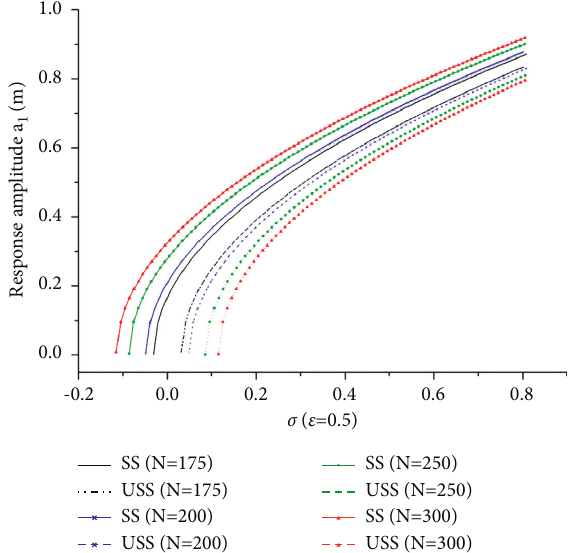
Figure 7: Curve of pedestrian number and lateral response am- � 0 . 007, ε � 0 . 5, 1 � 0 . 007, ε � 0 . 5, SS: stable solution, USS: plitude of footbridge ( 􏽢 ζ 1 unstable